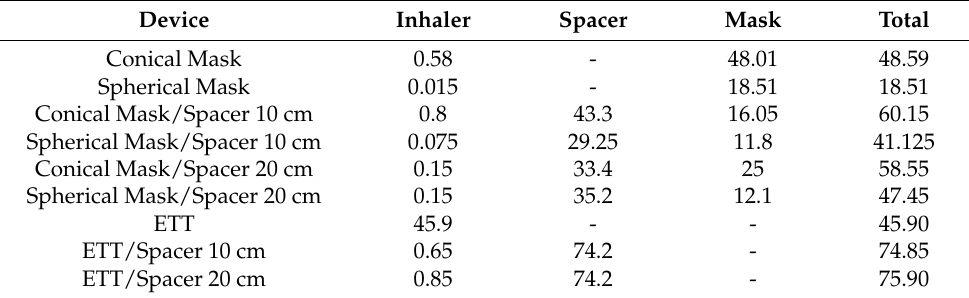
Table 3. Percentage of particles deposited to the different parts of the